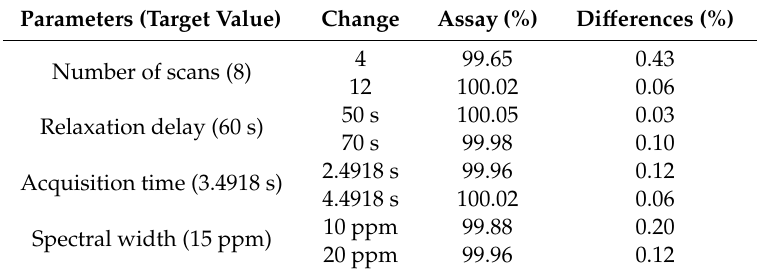
Table 5. Robustness analysis of scopoletin using